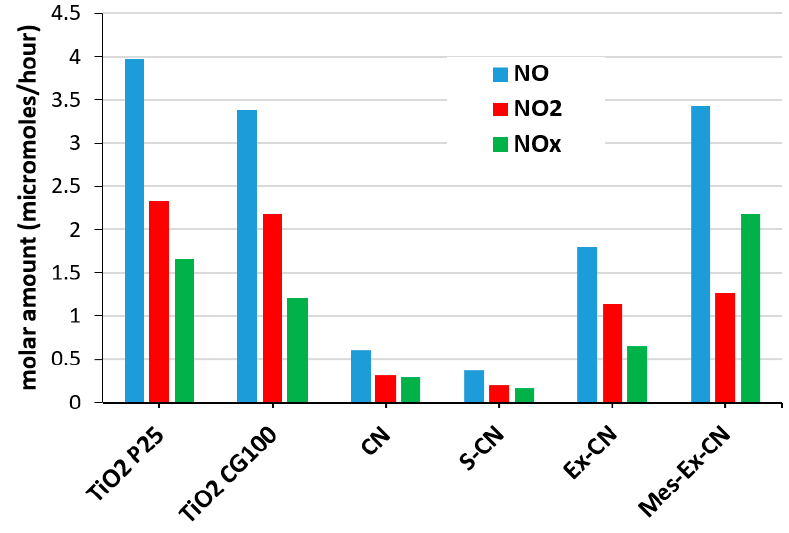
Figure 7. Amount of removed NO, formed NO 2 and totally removed NO x , respectively, under UV irradiation for 1 h.